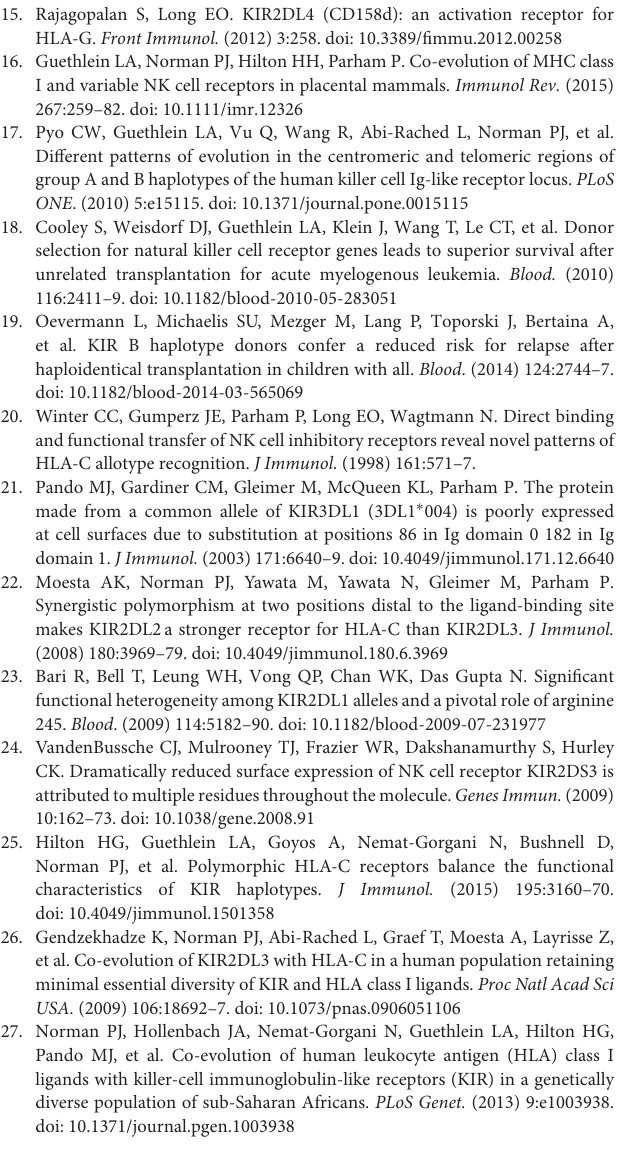
Supplementary Material (Spreadsheet) | (A) Shown are the allele frequencies for the 13 KIR genes in five Iranian populations, and the combined frequency is shown at the right. (B) Shown are the centromeric KIR haplotypes identified in five Iranian populations. The combined frequency is shown at the right. KIR A haplotypes are shaded in red, KIR B haplotypes are shaded in blue. (C) Shown are the telomeric KIR haplotypes identified in five Iranian populations. The combined frequency is shown at the right. KIR A haplotypes are shaded in red, KIR B haplotypes are shaded in blue. Yellow shading indicates novel KIR alleles identified in this study, which are described in Figure 2 . (D) Shows the HLA class I allele frequencies observed in the Baloch